Question: Briefly state, in one sentence, what is plotted here.
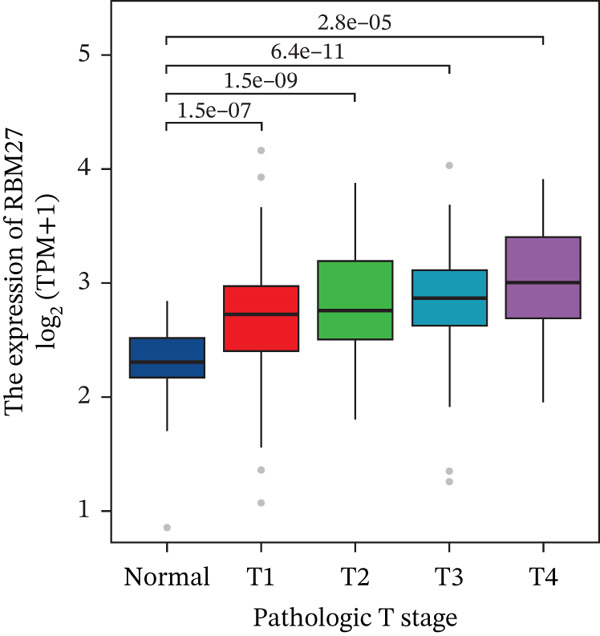
Answer: Correlation of RBM27 expression with clinicopathological characteristics. (a) T stage. (b) N stage. (c) M stage. (d) Pathological stage. (e) Tumor status. (f) Gender. (g) Age. (h) BMI. (i) Weight. (j) Vascular invasion. (k) AFP level. (l) Fibrosis risk score (Ishak fibrosis score grouping: 0 = no fibrosis ; 1–2 = mild fibrosis ; 3–4 = moderate fibrosis ; 5–6 = cirrhosis ). ∗ p < 0.05, ∗∗ p < 0.01, ∗∗∗ p < 0.001.